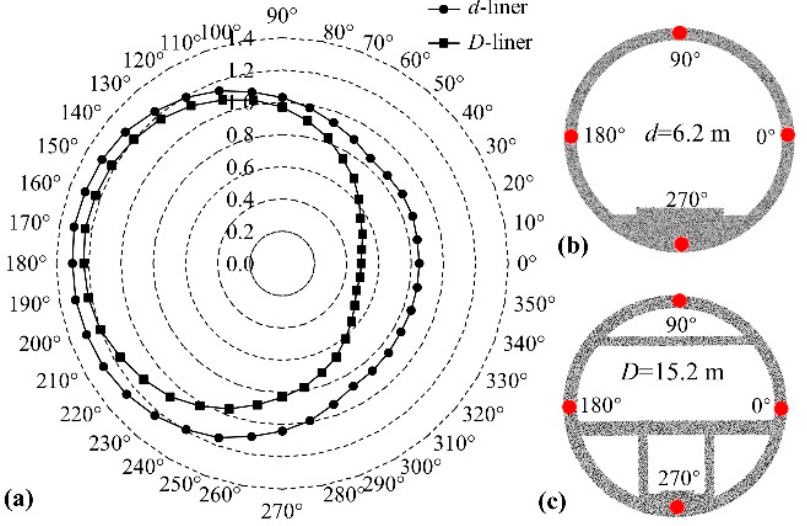
Figure 15. Comparison of resultant displacement of t2 and T2: ( a ) maximum value of resultant displacement; ( b ) measurement points of t2; ( c ) measurement points of T2. The resultant displacement on the right side of the t2 liner is much larger than that of the T2 liner. The possible reason for this is the fact that the distance between the monitoring point of the right-side liner of the T2 and the vibration point of the train in T1 is very large. The energy dissipation of the vibration wave of the train is basically completed. The research results of d tunnel can not be directly applied to the engineering of the D tunnel; it is necessary to strengthen the related research of the super-large diameter tunnel. Figure 16 shows the comparison of maximum and average values of resultant veloci- ties between t2 and T2. The maximum and average values of the velocity in t2 and T2 have basically the same variation rule, both of which are larger on the left side of the liner and smaller on the right side of the liner. Moreover, the velocity of the T2 is about 50% of that value of the t2; this indicates that the D twin tunnel is more stable than the d twin tunnel, which may be the result of the joint action of the larger space between the D twin tunnels and the greater water pressure around D twin tunnels. In addition, different sections of small and super-large diameter twin tunnels may also play an important role. The super-large twin tunnels have been stiffer due to the inner walls (Wall_1, Wall_2, Wall_3, and Wall_4) were added to them. Figure 17. Positive values represent tensile stresses, and negative values represent com- pressive stresses. The absolute value of σ x at 0 ◦ and 180 ◦ of T2 liner are greater than that of the t2 liner, and the variation amplitude of σ x is smaller in the train vibration process (Figure 17a). The change of σ y at 90 ◦ and 270 ◦ is similar to that of σ y in t2 and T2 (Figure 17b). In addition, special attention needs to be paid to the monitoring points where the tunnel liner exhibits high tensile strength, as the concrete liner has a strong compressive strength and a weak tensile